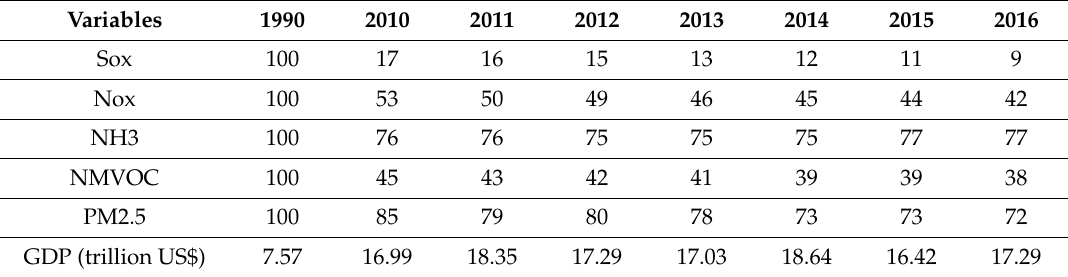
Table A1. The emissions of air pollutants index of European Union